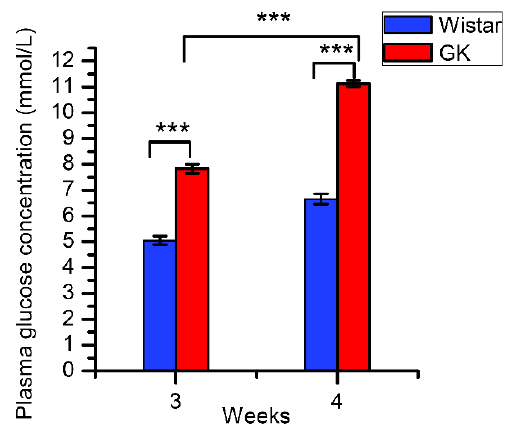
Figure 1. The random plasma glucose concentration of Goto-Kakizaki (GK) and Wistar rats (data are shown as mean ± SEM. n = 10, *** P < 0.001).